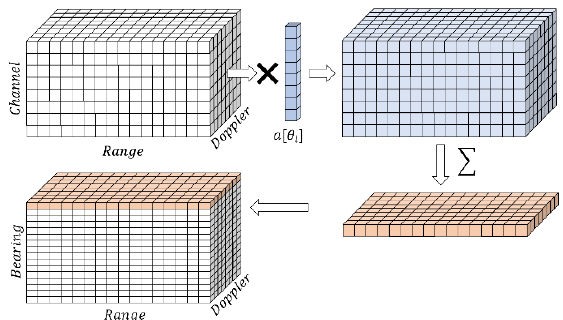
Fig. 6. GPU Implementation of Bartlett DOA